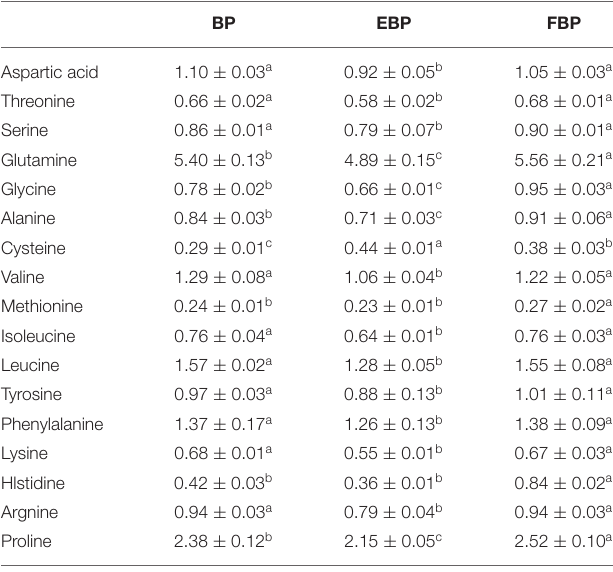
TABLE 5 | WSI and WAI of BP, EBP, and